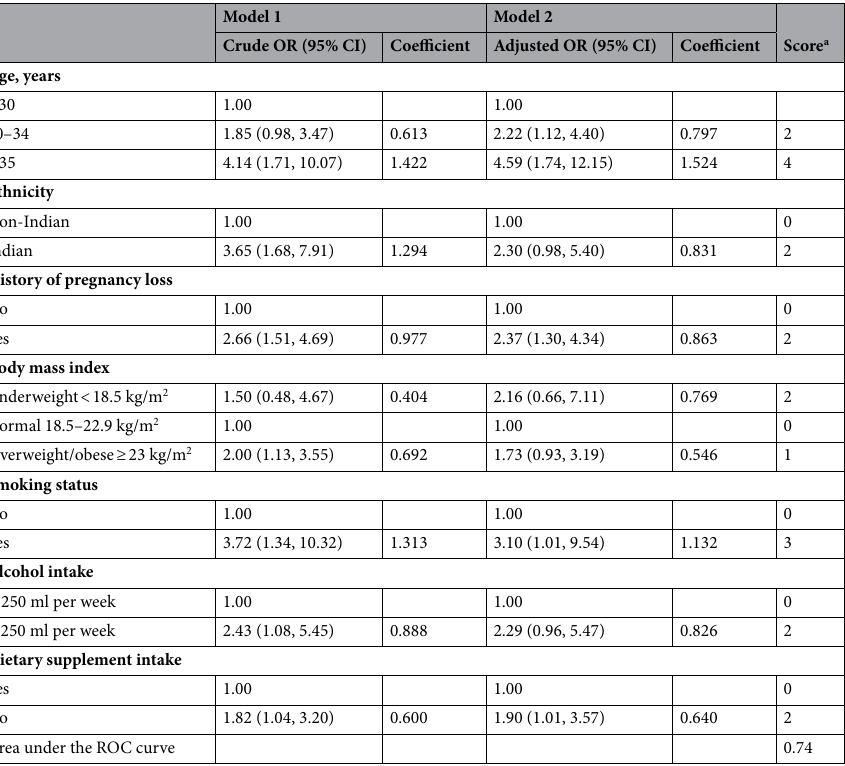
Table 2. Preconception risk factors for miscarriage < 16 weeks gestation, from the S-PRESTO study (n = 465). S-PRESTO Singapore PREconception Study of long-Term maternal and child Outcomes, OR odds ratio, CI confidence interval, ROC receiver-operating-characteristic. a The risk score values were estimated based on